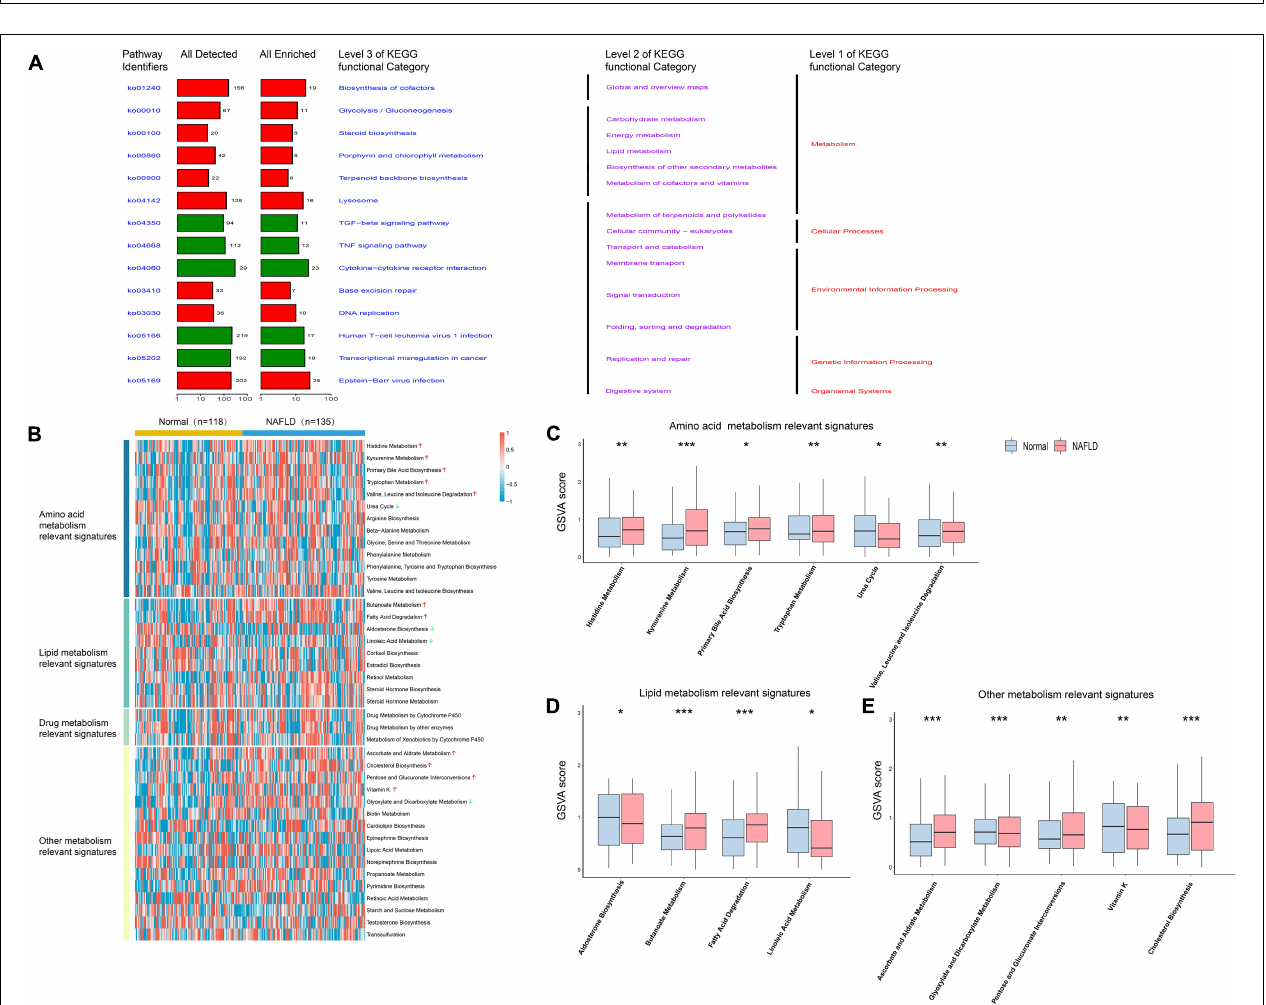
FIGURE 1 | Differentially expressed genes. (A) Schematic diagram of the study design. (B) Two-dimensional PCA plot of the combined expression profile. (C) Volcano of differentially expressed genes. The red dots represent up-regulated genes while the green dots represent down-regulated genes.